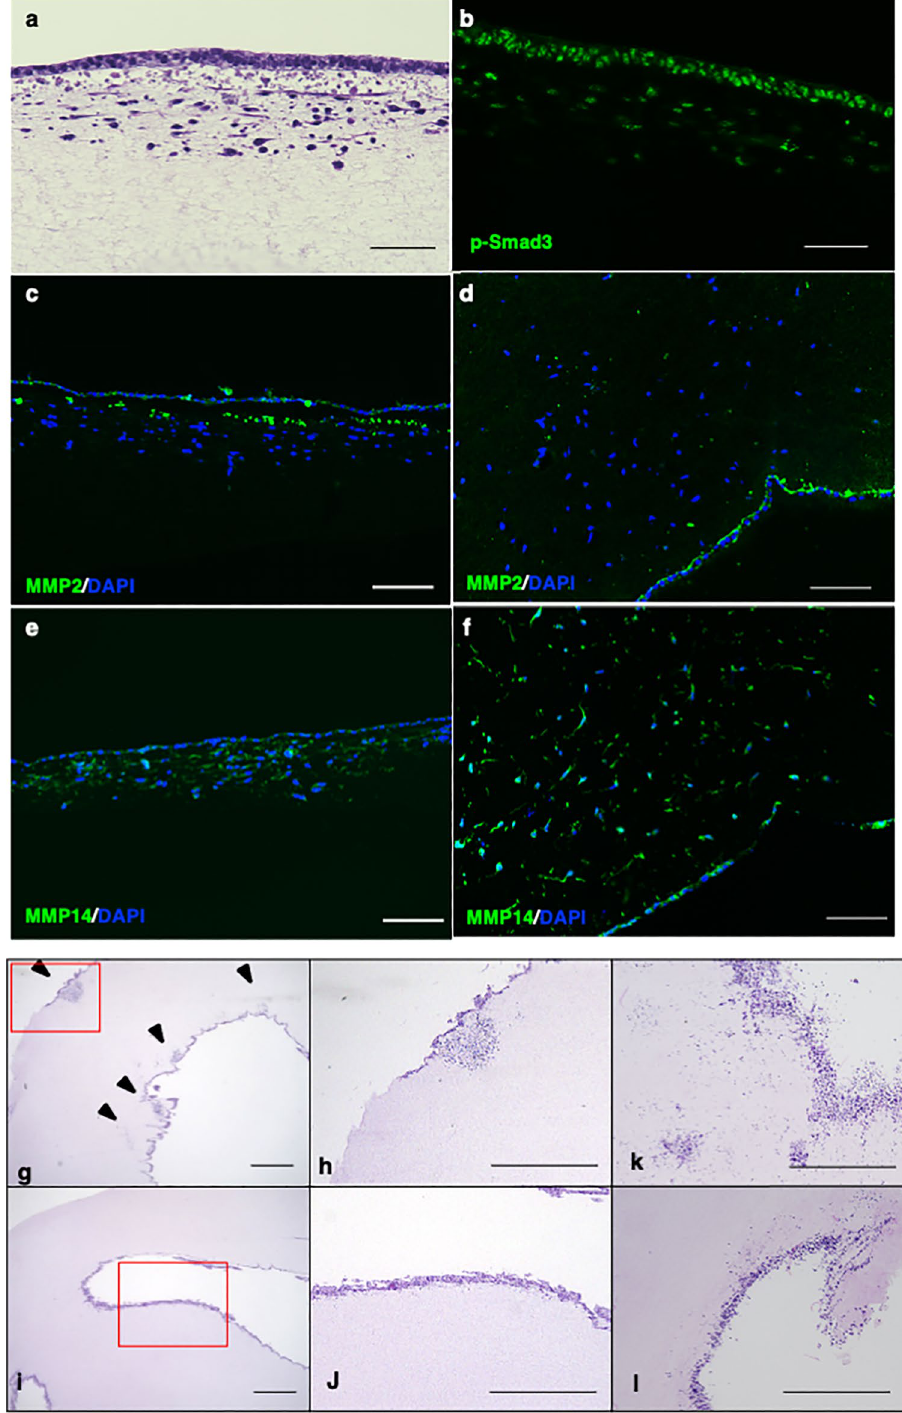
Figure 5. Cell invasion required the activity of MMP. Histological findings of osteogenic induced hiPSCs (414C2) on type I collagen gel at day 14. Cells cultured with collagen gel were stained with Hematoxylin–Eosin (HE) ( a ), antibodies for p-Smad3 (green) ( b ), MMP2 (green) and DAPI (blue) ( c , d ), or MMP14 (green) and DAPI (blue) ( e , f ). Images from vertical ( a , b , c , e ) and horizontal ( d , f ) sections are shown. Scale bars = 100 μm. Histological findings of osteogenically induced hiPSCs ( g – j ) or MLO-Y4 ( k , l ) at day 14 in vertical sections by HE staining. Cells were treated without ( g , h , k ) or with ( i , j , l ) GM6001 (25 μM). ( h , j ) are enlarged views of the red-framed areas in ( g ) and ( h ), respectively. Arrowheads in ( g ) indicate invading cells. Scale bars = 1